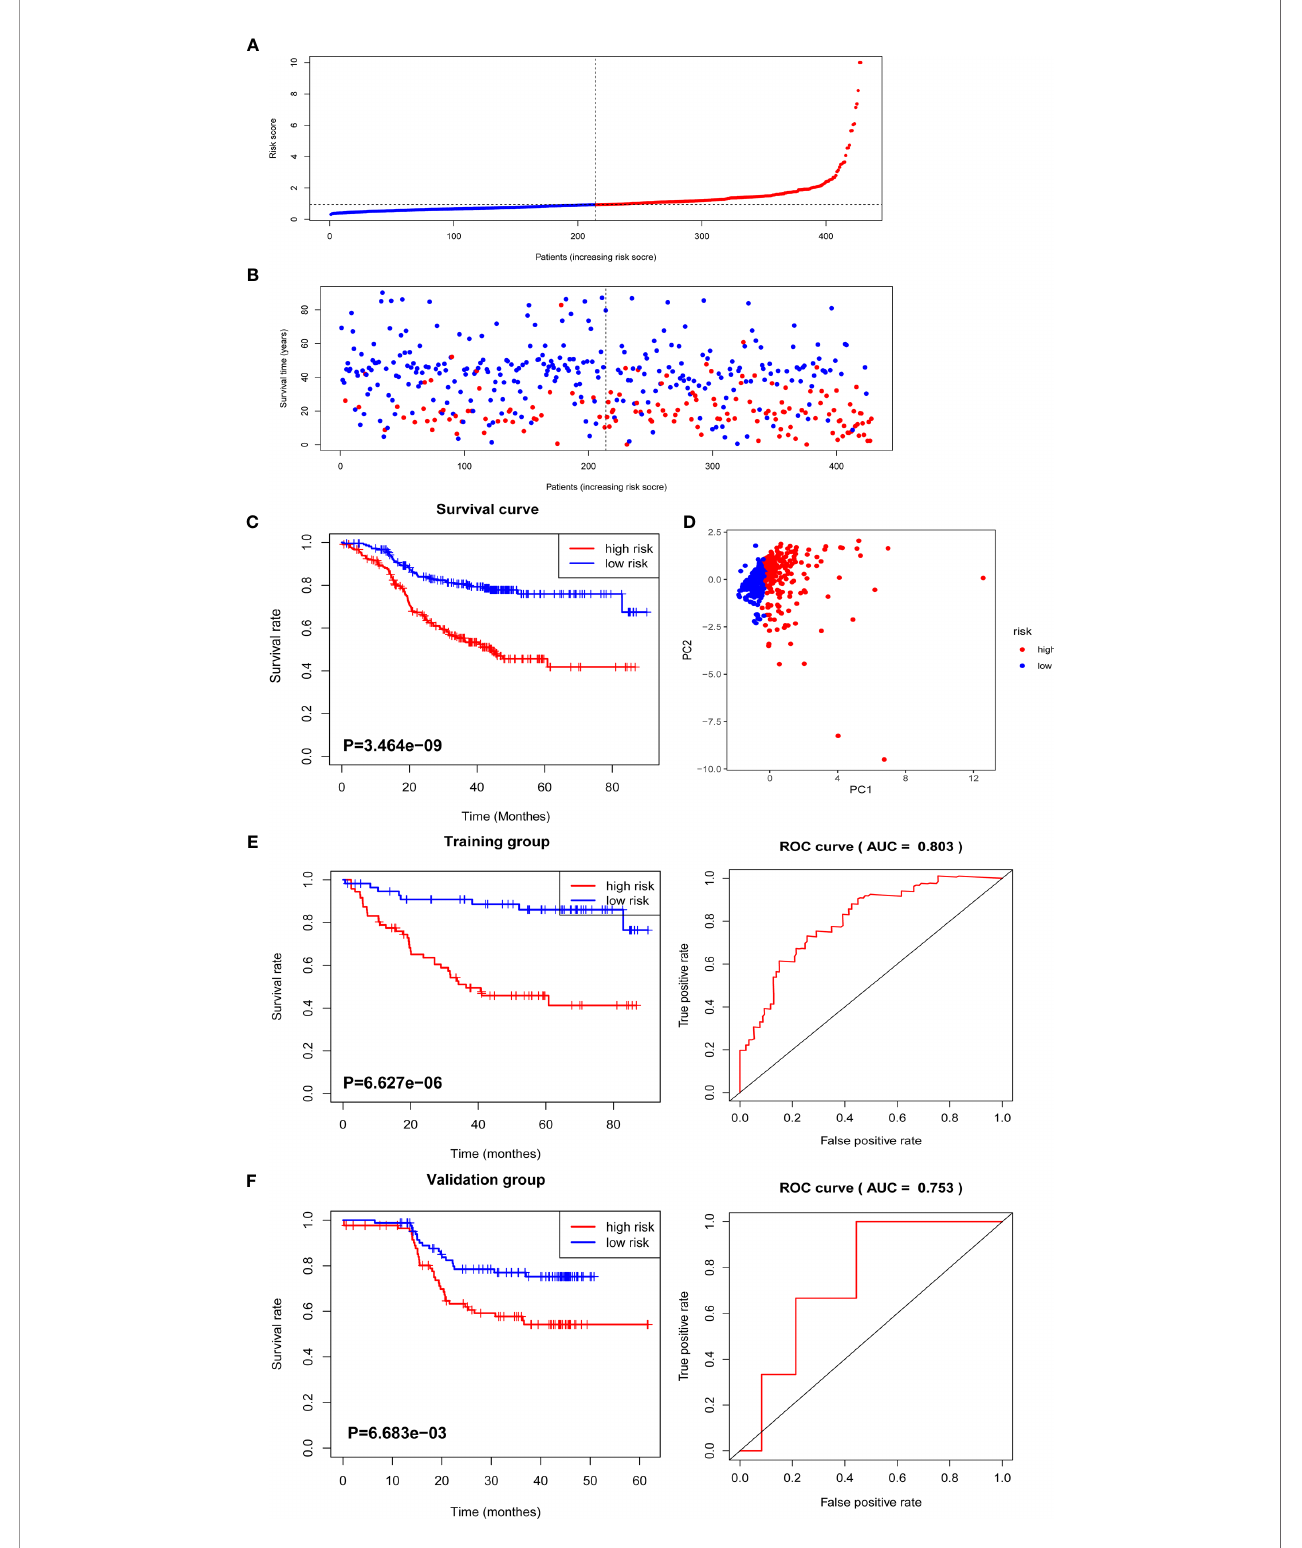
FIGURE 3 | The distribution of radiomics score and overall survival analysis. (A) The distribution of the radiomics score of GC patients. (B) The overall survival status for each GC patient. (C) Overall survival curve of total GC patients. (D) PCA depicts the variation of high- and low-radiomics scores. (E) Overall survival and ROC curves of the training group. (F) Overall survival and ROC curves of the validation